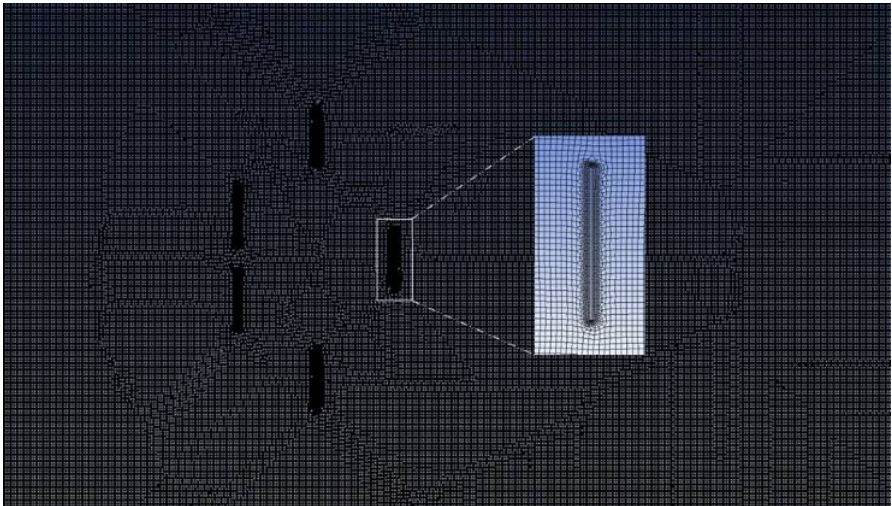
Figure 8. Discretized model of the pentagon configuration.